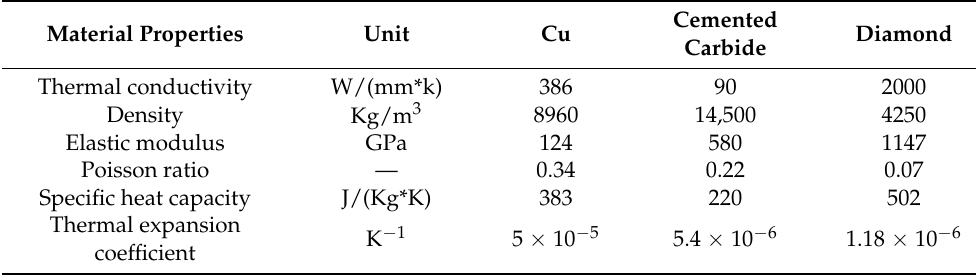
Table 2. Physical parameters of Cu [18], cemented carbide [19] and diamond [20].